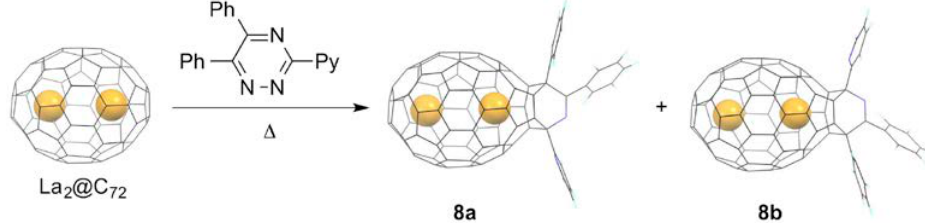
Figure 3. Cage-opening reaction of La 2 @C 72 with 5,6-diphenyl-3-(2-pyridyl)-1,2,4-triazine.